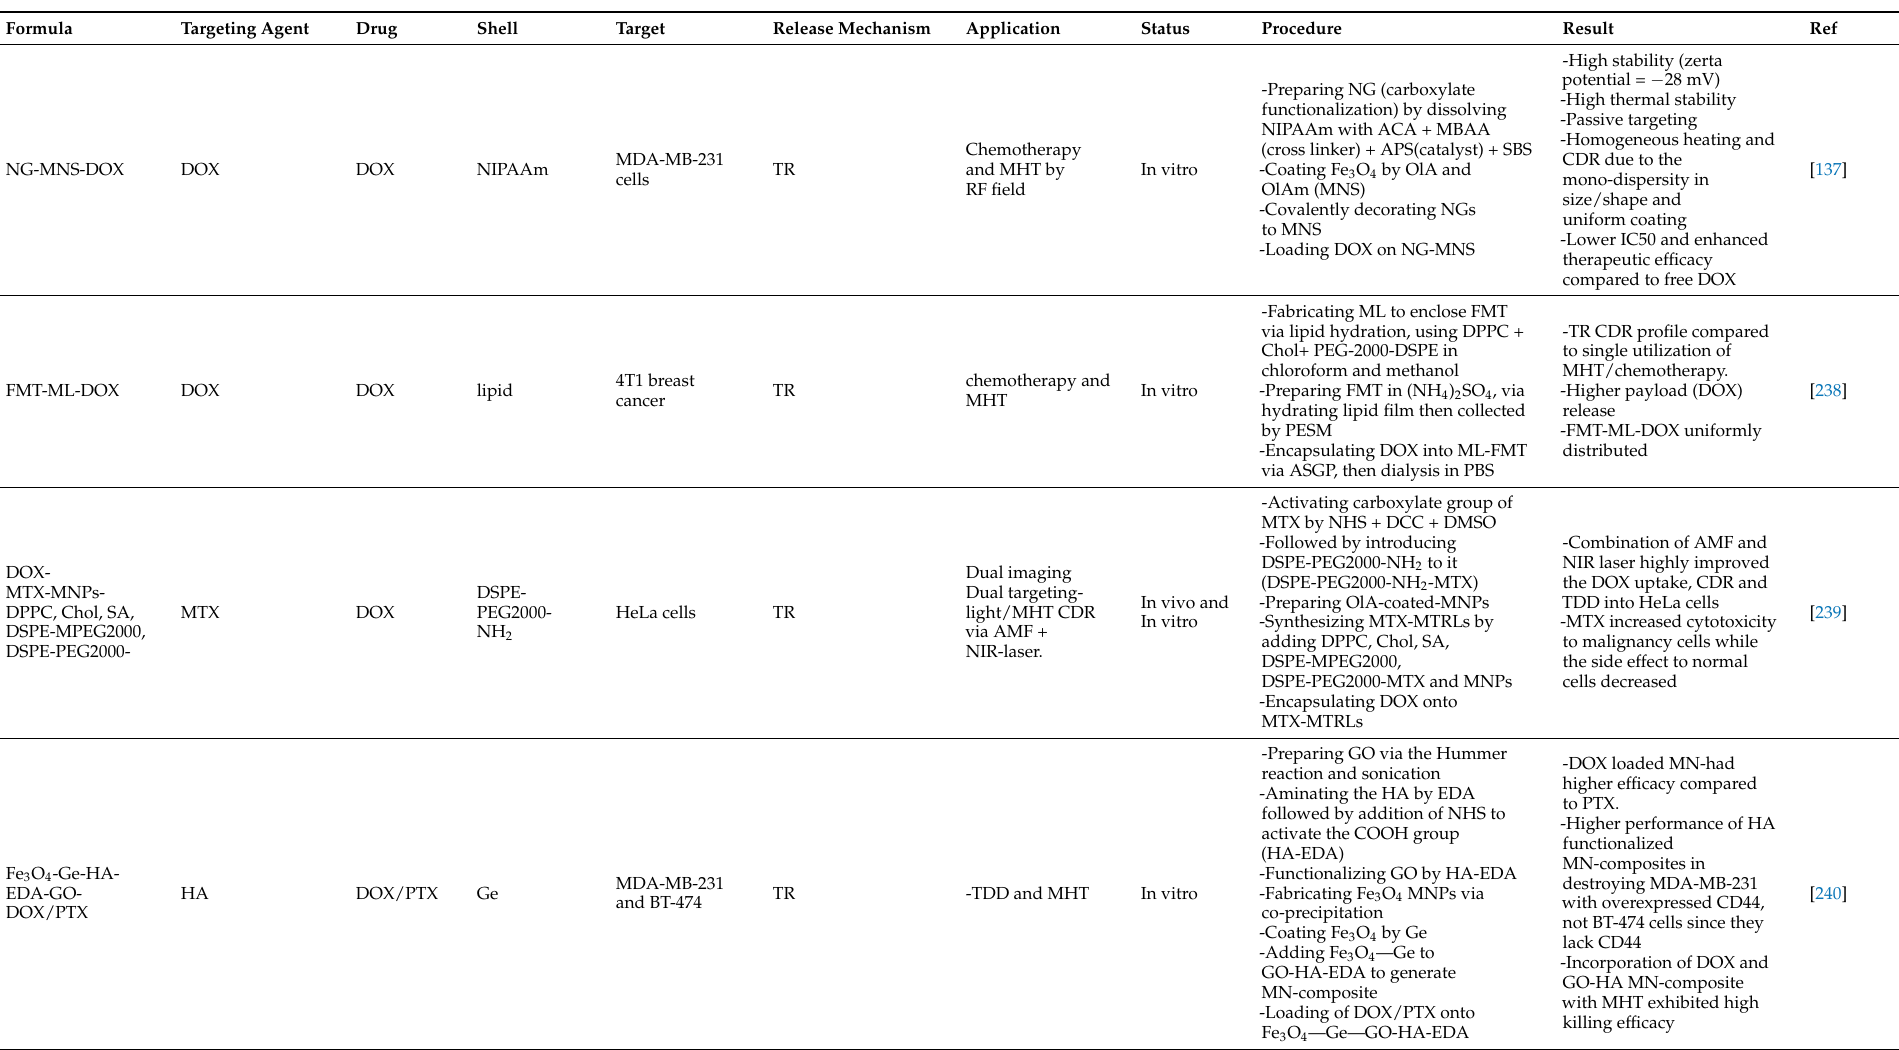
Table 7. The studies of application of MNPs in MHT therapy and CDR for theranostic